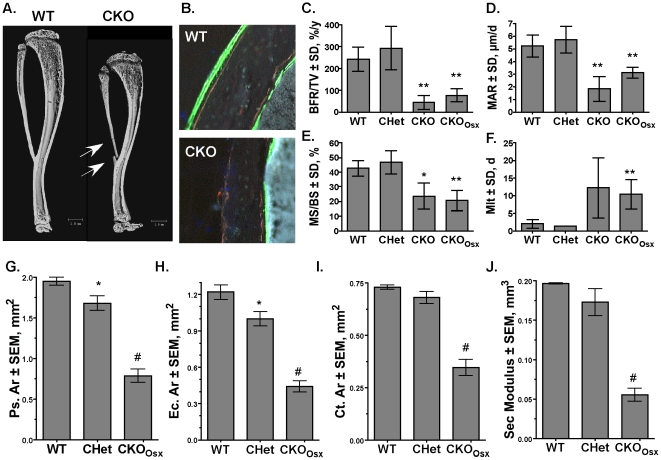
Cortical bone is thinner in Hdac3 CKO mice.A. MicroCT reconstructions of tibia and fibulas from WT and Hdac3 CKO mice. Arrows point to fractures. B–F. Calcein incorporation (B), bone formation rates (C), mineral apposition rates (D), mineralized surfaces (E) were decreased, while mineralization lag time (F) was increased in Hdac3 CKO mice (n = 5 WT and CKOOsx, n = 2 CHet, n = 3 CKO). G–J. Cortical measurements from microCT reconstructions demonstrate that periosteal area (Ps.Ar, G), endocortical area (Ec.Ar, H), Cortical area (Ct.Ar), which estimates axial strength (I), and section (Sec) modulus, an estimate of bending strength (J), were reduced in Hdac3 CKO mice (n = 3 per group). *p<0.05, **p<0.01, #p<0.0001.